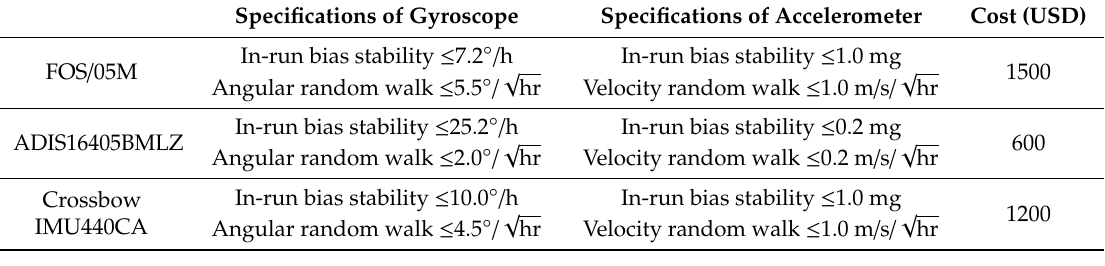
Table 1. Performance parameters of the inertial measurement units (IMUs). USD—United States dollars.